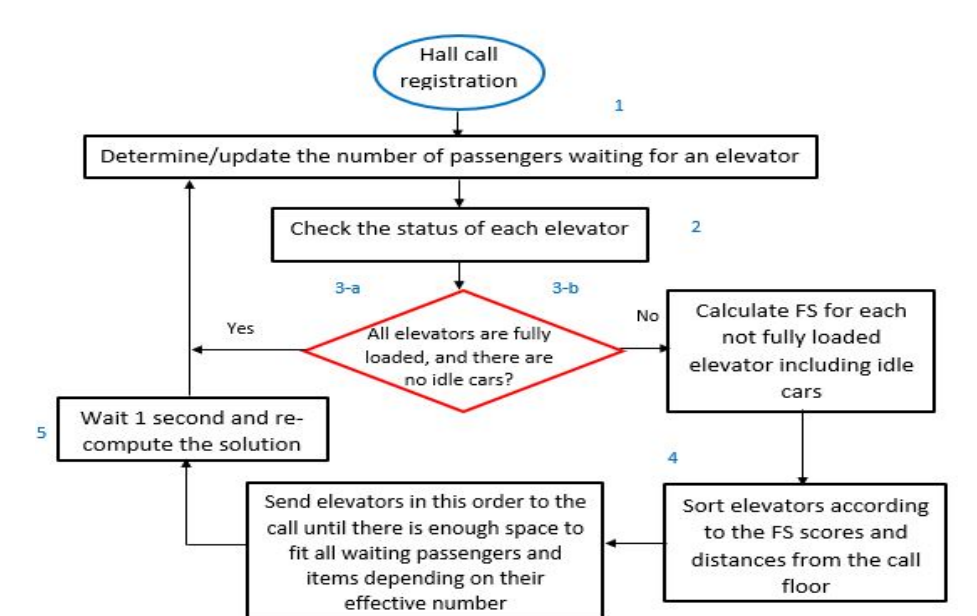
Figure 4. Flowchart of modified NC algorithm with BN.